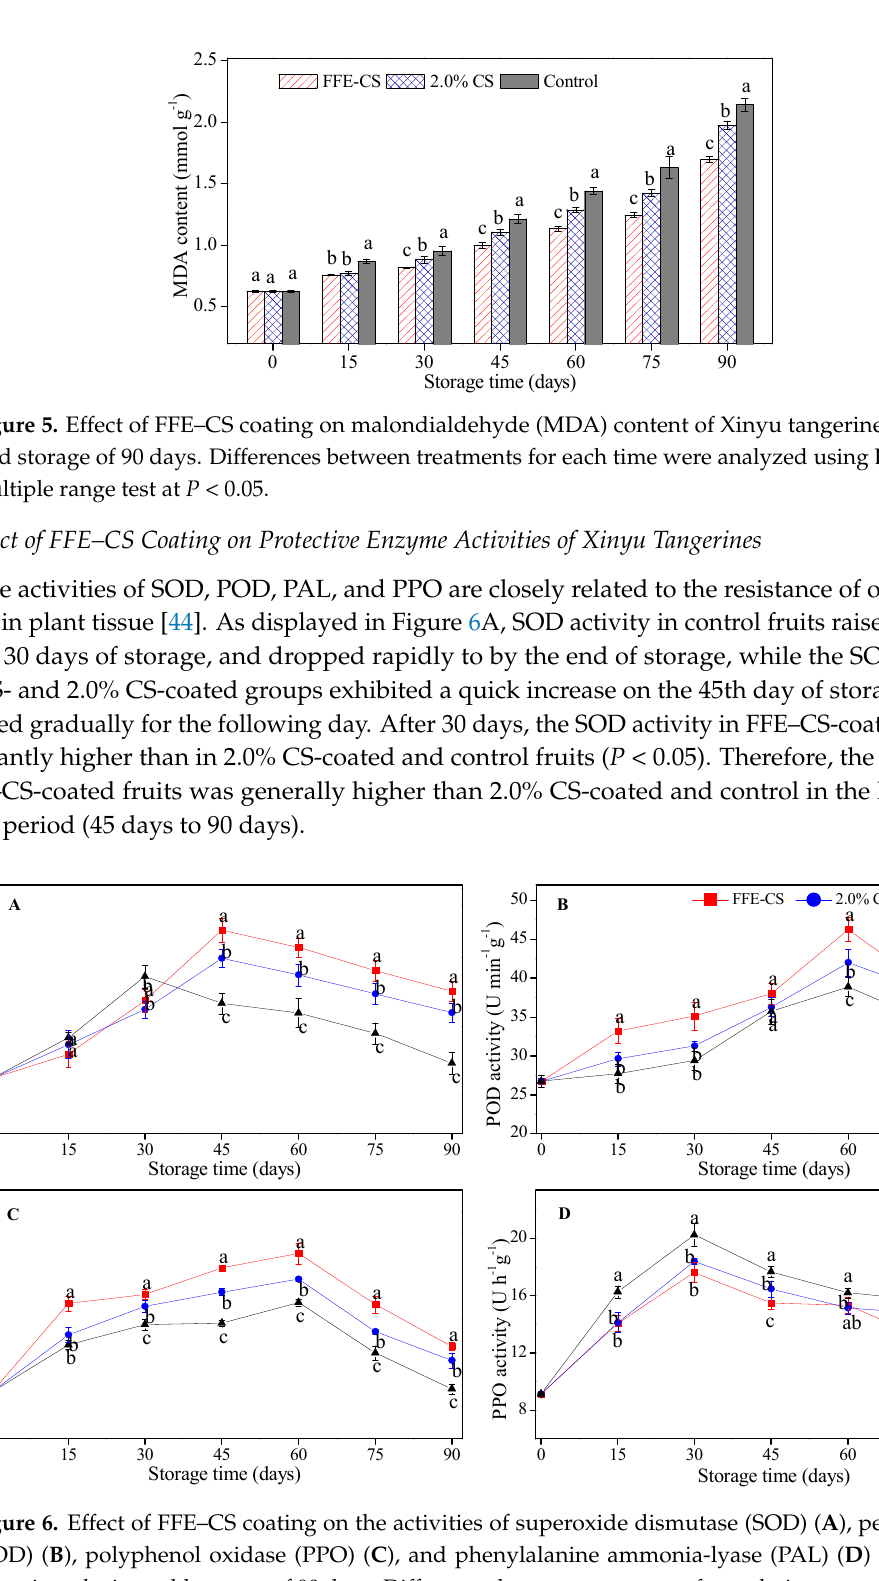
Control Figure 4. Effect of FFE–CS coating on respiration rate of Xinyu tangerines during cold storage for 90 days. Differences between treatments for each time were analyzed using Duncan’s multiple range test at P < 0.05. 3.5. Effect of FFE–CS Coating on MDA Content of Xinyu Tangerines MDA is the final product of lipid peroxidation, related to senescence, and is used as one of the direct indices of cell oxidative damage. As shown in Figure 5, the uncoated Xinyu tangerines (control) showed a rapid increase in MDA content, and this increasing trend continued to the end of cold storage, with the value increasing 2.45 times. The overall MDA content in the control group was significantly ( P < 0.05) higher than that in the two coated groups. Xinyu tangerines coated with FFE– CS showed a lower MDA content compared to 2.0% CS coating and control. These results are highly consistent with those of Chen et al. [10] and Shah et al. [31], where a slow rise in MDA was recorded in citrus fruits treated with 1.5% chitosan coating enriched with FFE, and CMC edible coating